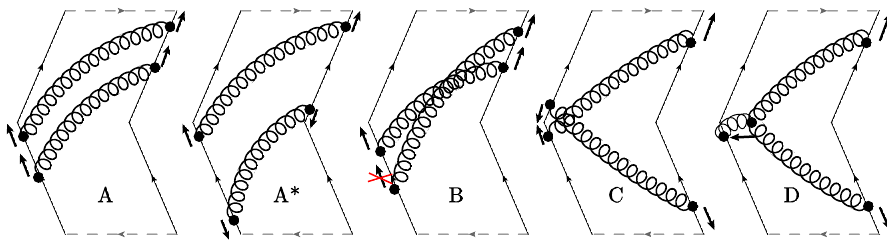
Figure 4 . Examples of two-loop diagrams studied in the text. The diagrams A , C and D has the second power of rapidity divergence which appears if the positions of vertices are limited ac- cording to arrows. The diagram B has the (cid:12)rst power of rapidity divergence, since the positions of vertices cannot be limited according to arrows successively. The other combinations of divergent limits